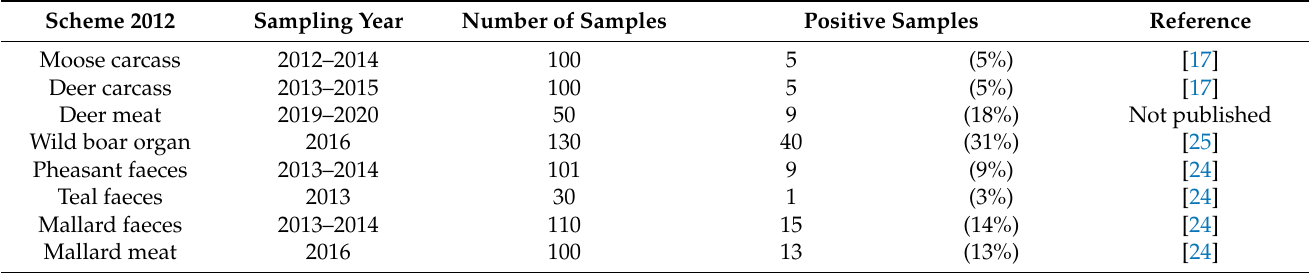
Table 1. Isolation rates of Listeria monocytogenes from hunted game and game meat in Finland